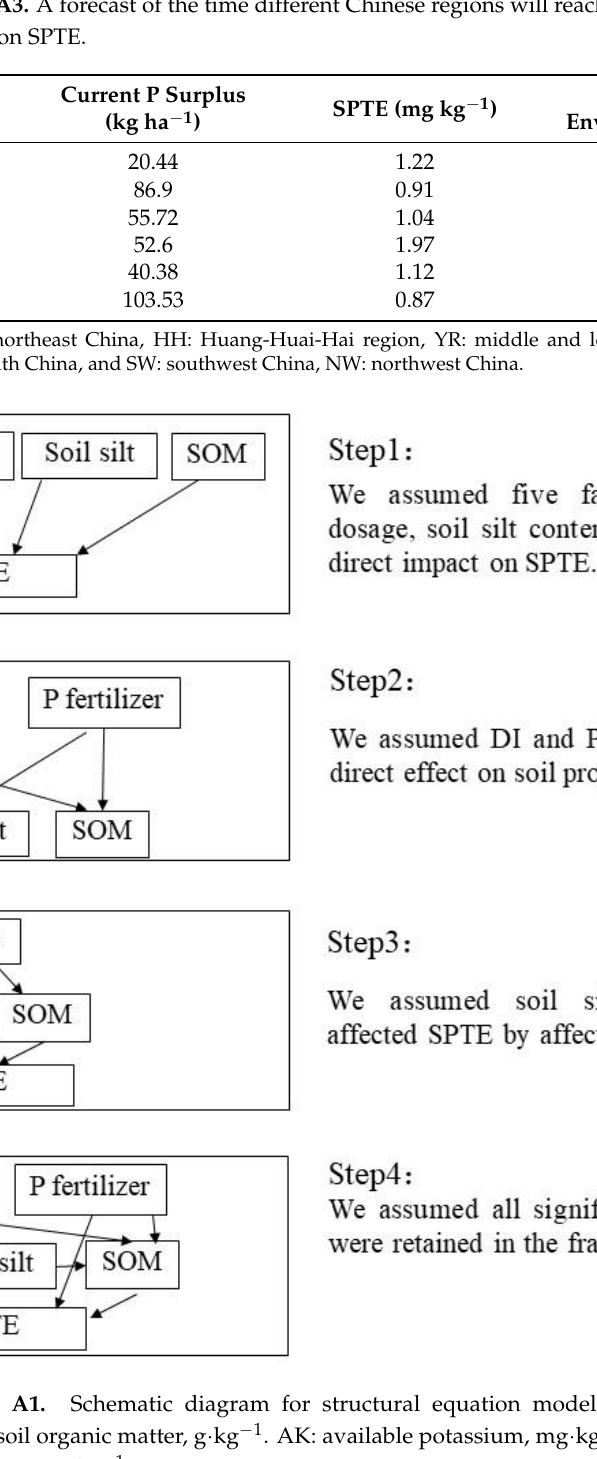
y = 0.5054x − 991.56 R² = 0.0382